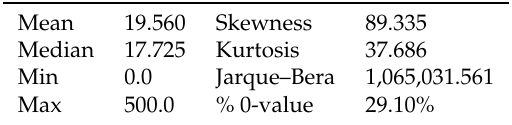
Table 3. Statistics of the FCR-N price data for 2015 and